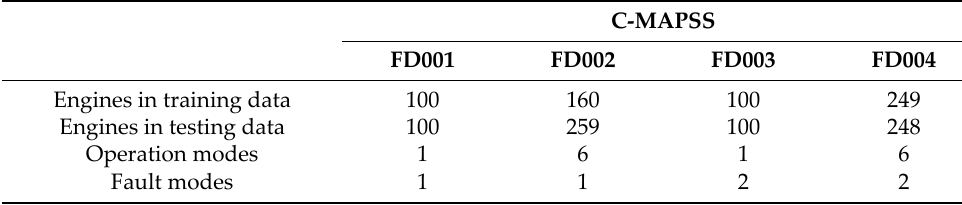
Table 1. Information of CMAPSS data